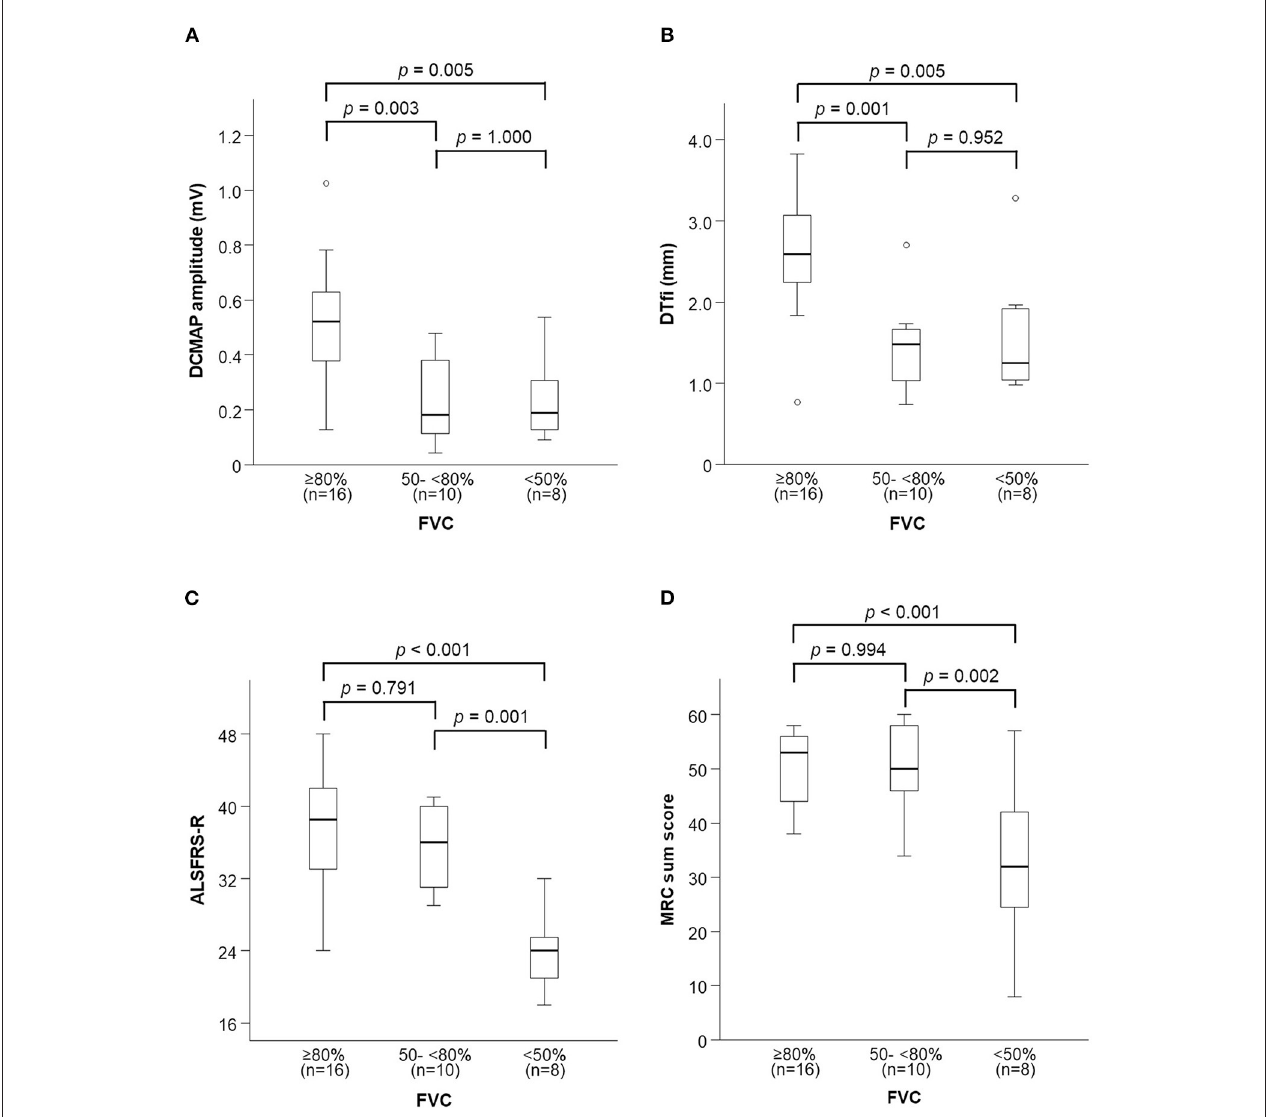
FIGURE 6 | Changes in neurophysiological parameters and general condition with FVC decline. (A,B) DCMAP amplitude and DTfi decrease only in the early stage of FVC decline. (C,D) ALSFRS-R score and MRC sum score decrease only in the late stage of FVC decline. FVC, forced vital capacity; DCMAP, diaphragmatic compound motor-action potential; DTfl, diaphragm thickness at full inspiration; ALSFRS-R, amyotrophic lateral sclerosis functional rating scale-revised; MRC, medical research